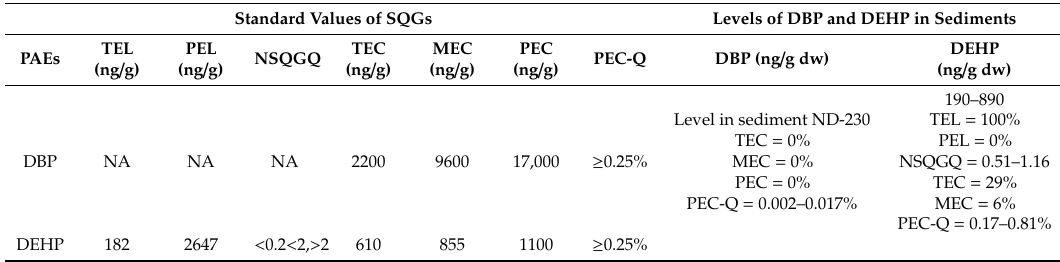
Table 5. Comparing the standard quality guidelines (SQGs) values of DEHP and DBP and levels in sediments of U-Tapao